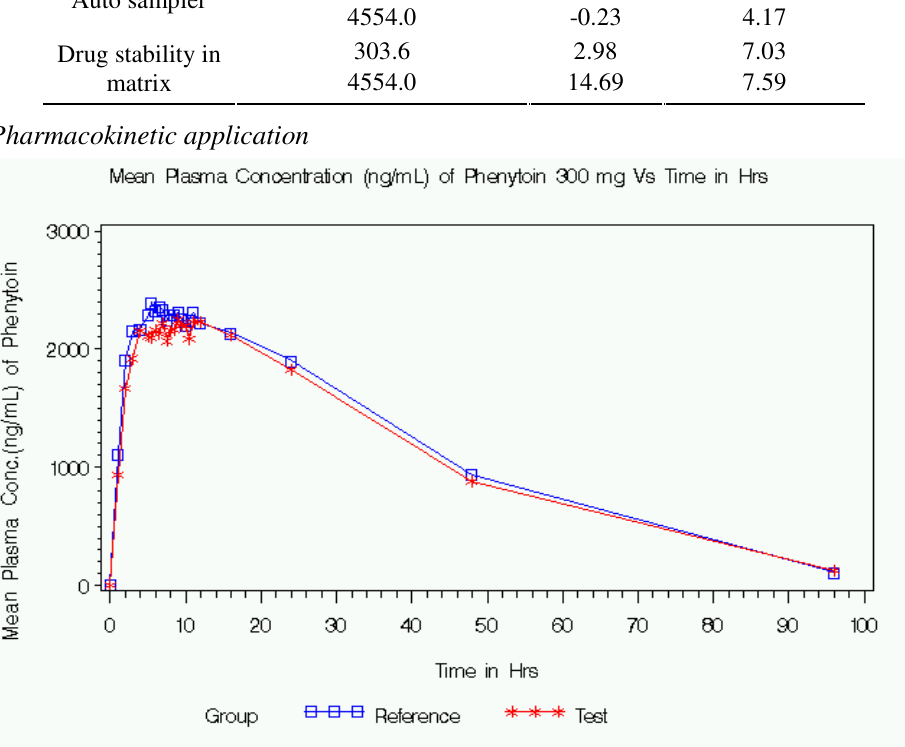
Figure 4 . The concentration time profile after a single oral dose bioequivalence study of phenytoin (300.0 mg)